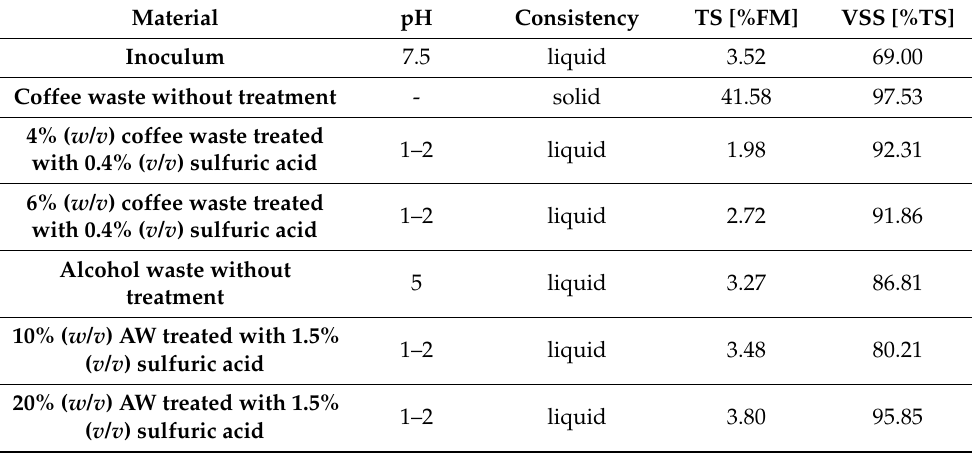
Table 1. The composition and characteristics of wastes and inoculum used in this